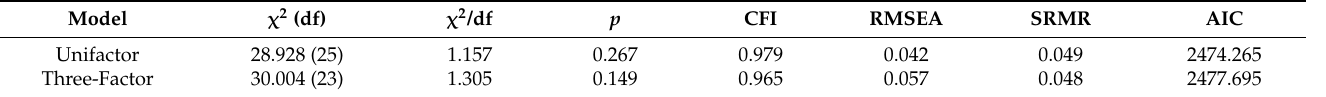
Table 4. Confirmatory factor analyses for 9-items* BELS scale in unifactor and 3-factor models.